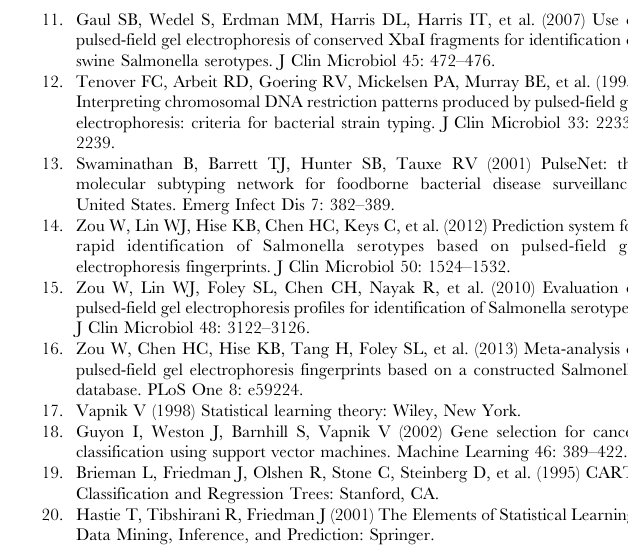
Figure S1 The prediction model divided the 97 patients into four subgroups using RF. The logrank test for differences among the four subgroups (0,0), (0,1), (1,0), and (1,1) was 0.717. Figure S2 The prediction model divided the 97 patients into four subgroups using DLDA. The logrank test for differences among the four subgroups (0,0), (0,1), (1,0), and (1,1) was 0.186. Table S1 Upper panel. Frequency distributions of classification patterns identified by the RF composite model (m1, m2, m3, m4) for the synthetic training dataset consisting of 4 subgroups, S1, S2, S3, and S4. Lower panel. Performance of the RF composite